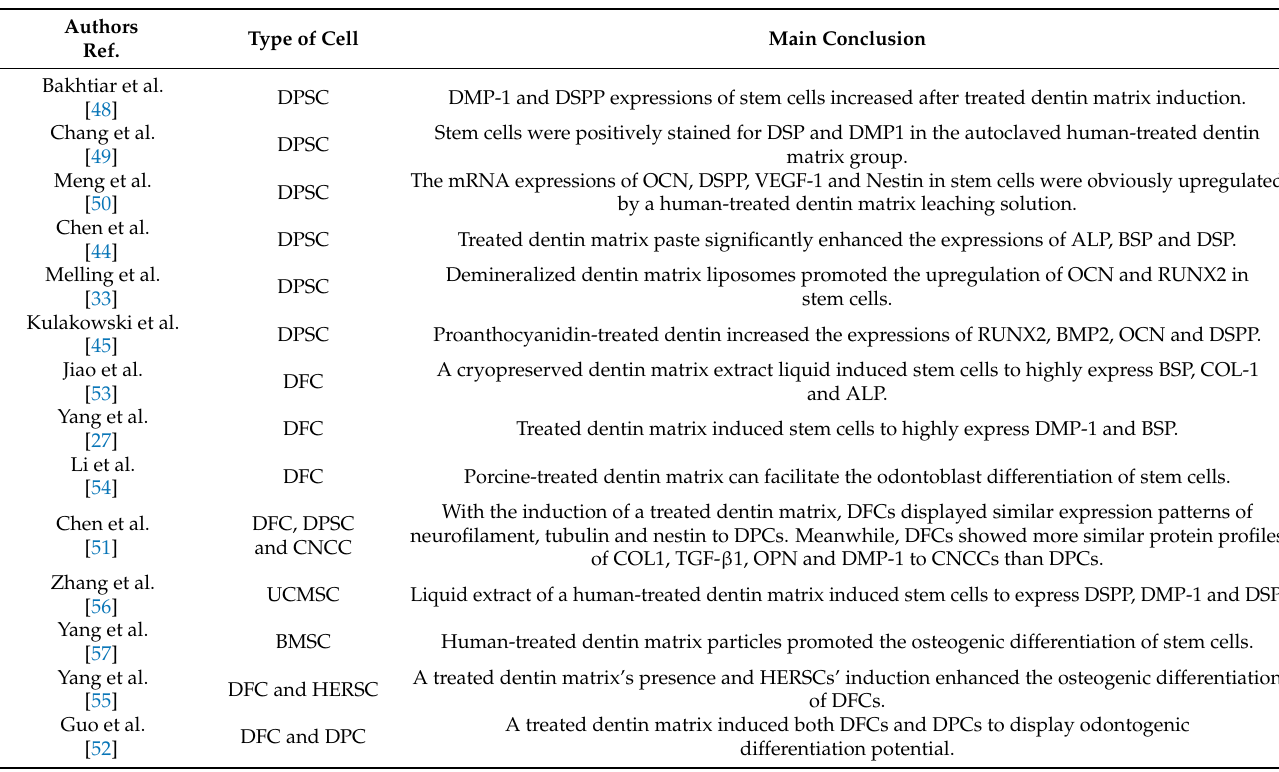
Table 2. Treated dentin matrix and its derivatives’ effects on cell